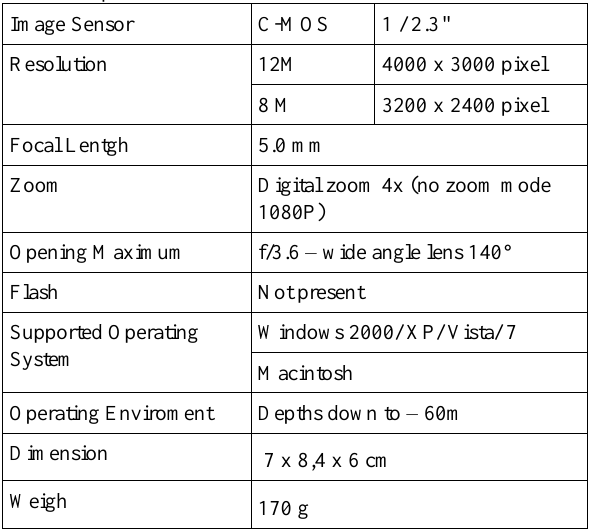
Table 2. Main characteristics of Intova